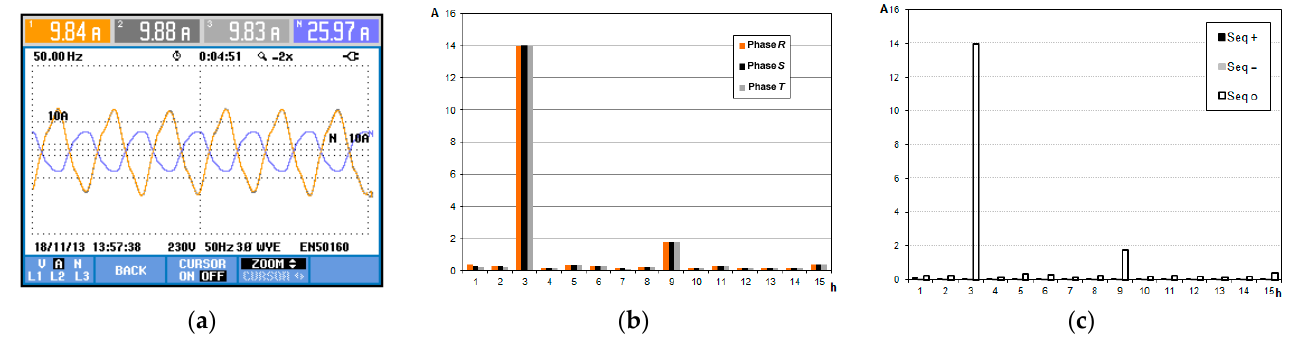
Figure 32. Measurements in the ZSF: ( a ) three-phase currents; ( b ) harmonic spectrum of the currents; ( c ) harmonic spectrum of the current sequence components (maximum values).